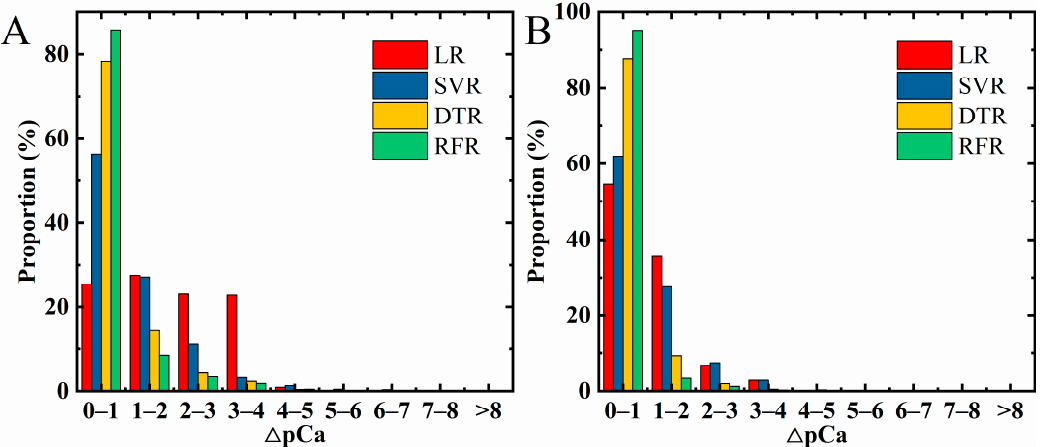
Figure 5. Evaluation results of regression models by using algorithms of LR, SVR, DTR and RFR: ( A ) regression models of output features; ( B ) regression models of transfer features.